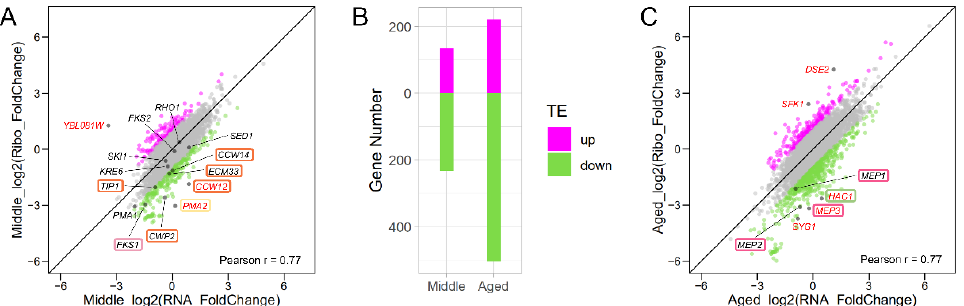
Figure 2. Global analysis of translational efficiency changes in Middle and Aged yeast cells. ( A ) Translational efficiency changes in Middle cells. Genes with translational efficiency increases of more than twofold (magenta), no notable changes (grey), and decreases of more than twofold (green) are plotted. Genes with markedly altered translational efficiency are shown in black with red gene name. Genes with markedly altered translational efficiency are shown in colorful boxes, same color means in a same group. Young yeast cells were used as the control. ( B ) Genes with upregulated and downregulated translational efficiency (TE) in Middle and Aged cells are shown. ( C ) Translational efficiency changes in Aged cells. Color legend is identical to ( A ).